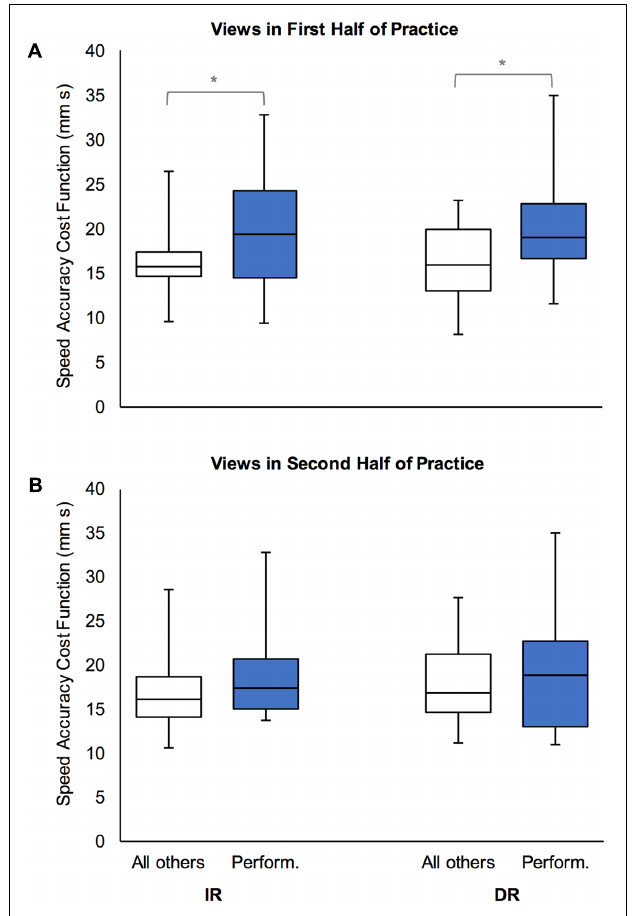
FIGURE 6 | Box and whisker plots of performance efficiency (as measured by the speed accuracy cost function) for each retention test (IR: immediate retention; DR: delayed retention), by views of haptic assistance expressed regarding the first (A) and second (B) halves of skill acquisition. Views of haptic assistance are indicated by “Perform.” (performance view) or “All others” (all other views: negative, neutral/mixed, and positive for learning). ∗ p <